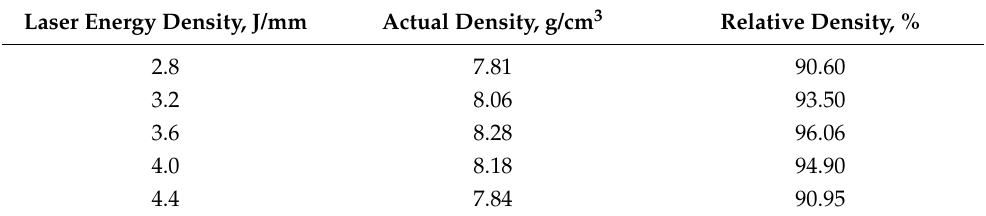
Table 2. Density of LMD-processed specimens at different processing